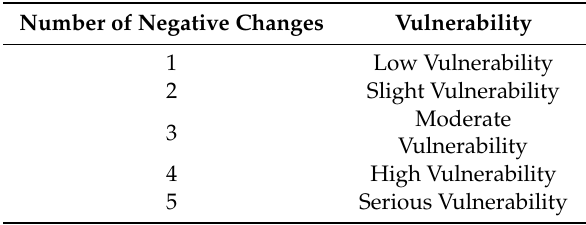
Table 1. Vulnerability level classification